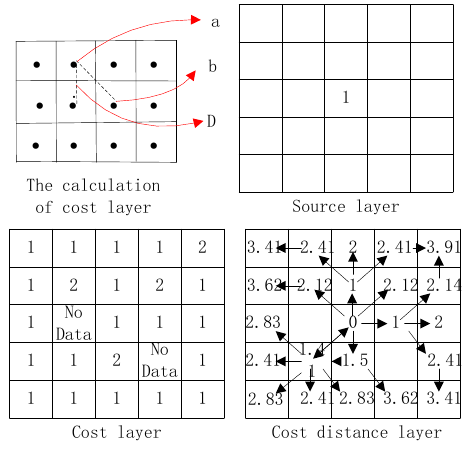
Figure 2. Areas surrounded by new and old delimitation line